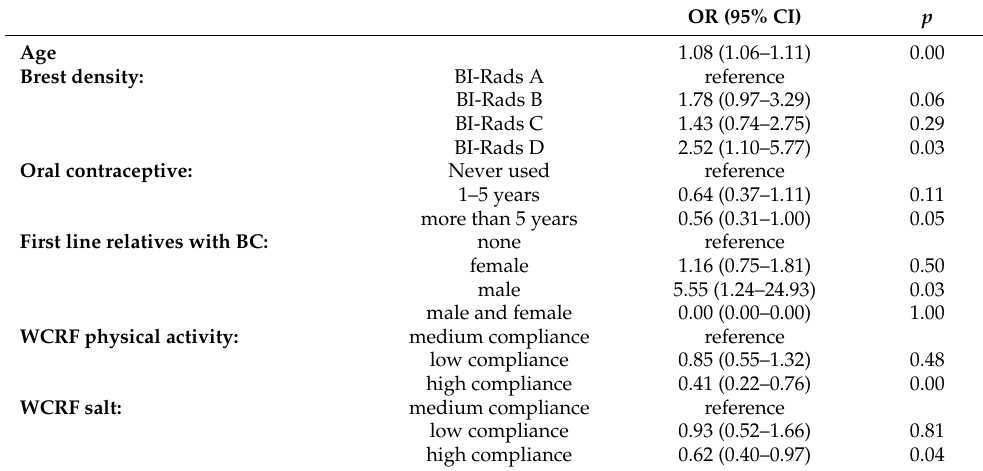
Table 4. Multivariate Logistic Analysis: protective or predisposing factors effects on BC (all menopause women).